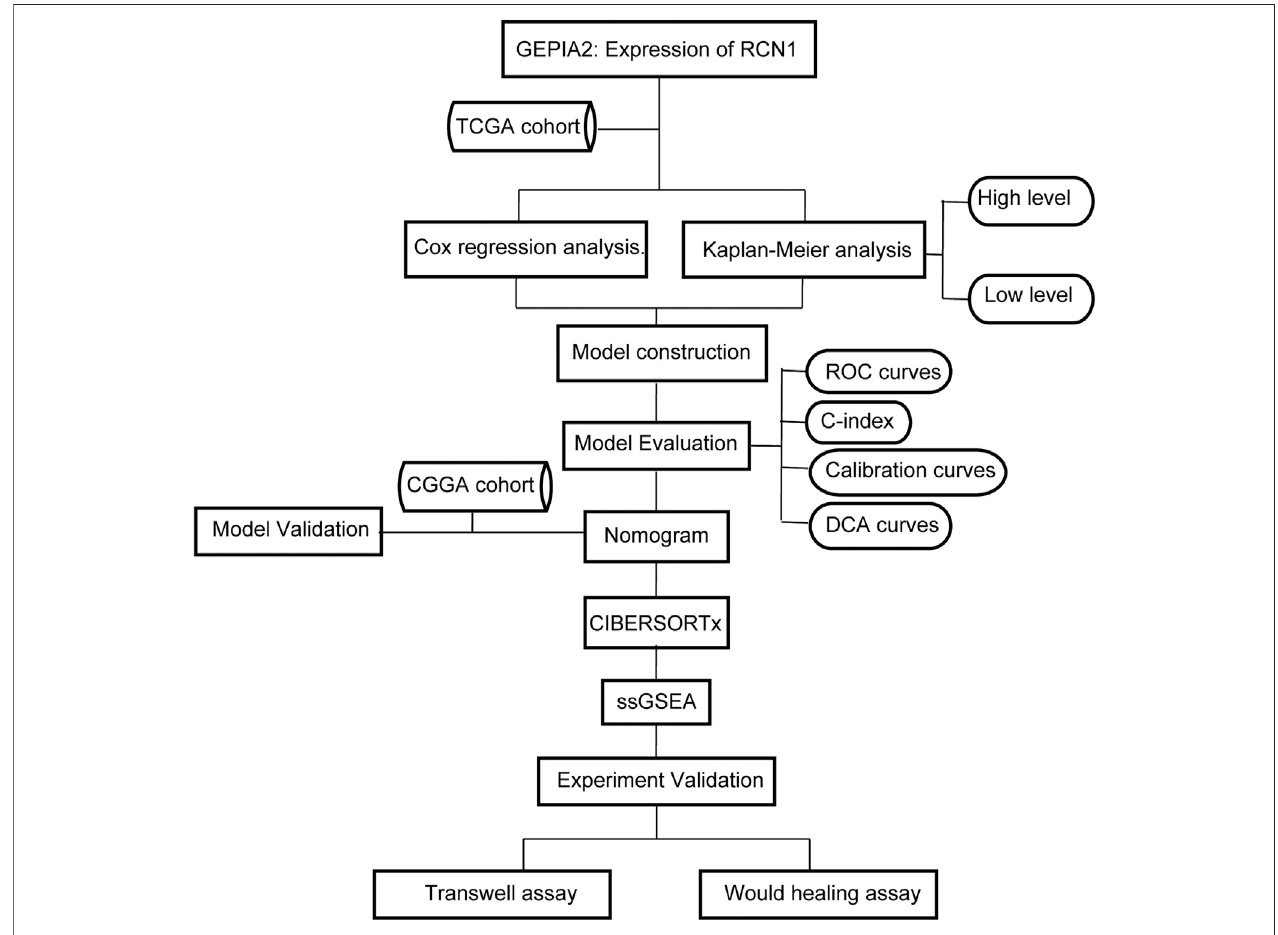
FIGURE 1 | Flow chart of this